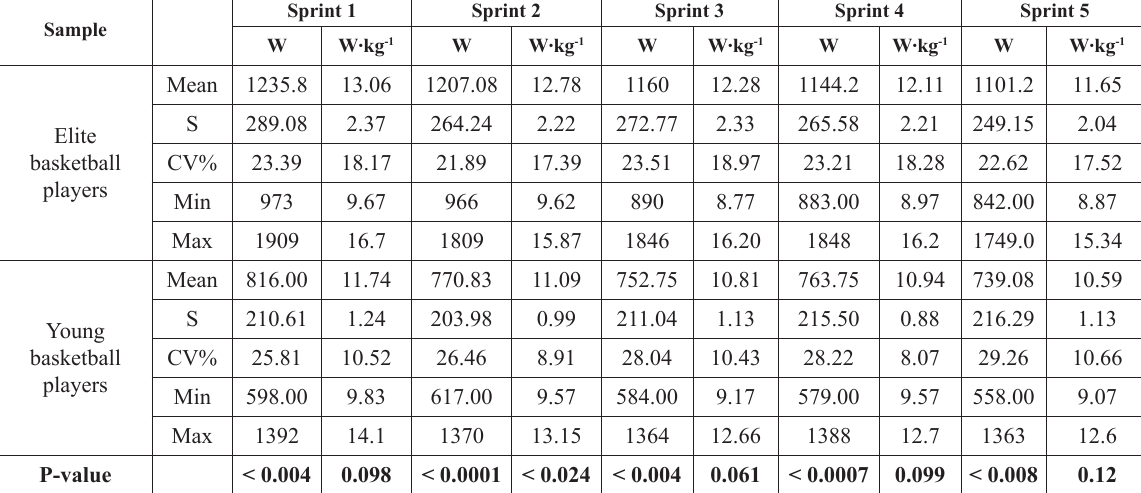
Figure 1. Change in absolute muscle power (W) of elite and young basketball players Table 1. Muscle power of elite and young basketball players performing 5 × 6 s repeated effort test performing 5 × 6 s repeated effort test